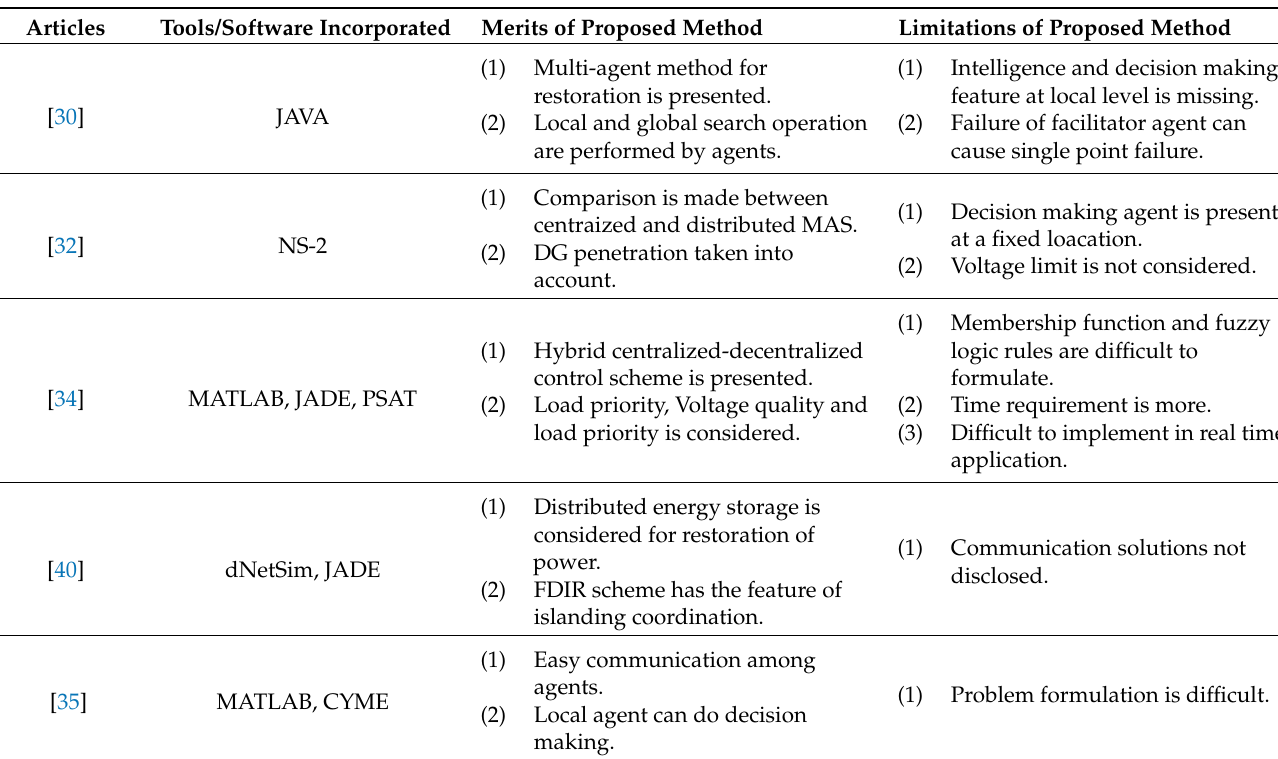
Table 1. A comparison of several agent-based distribution automation techniques.